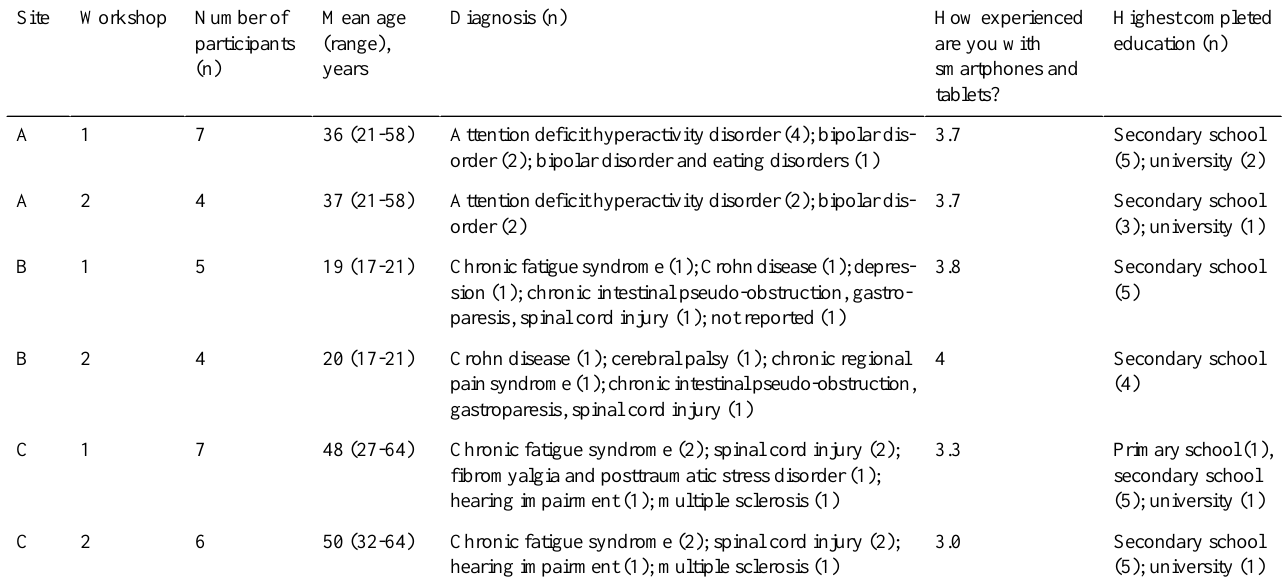
Table 1. Participant